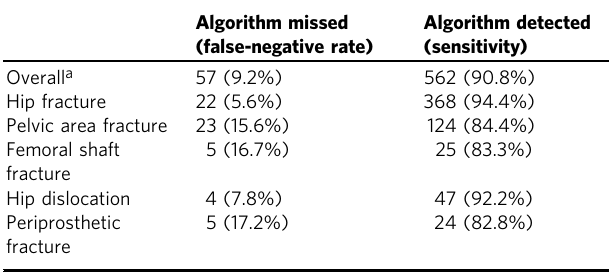
Table 2 Statistics of the algorithm missed and detected trauma fi